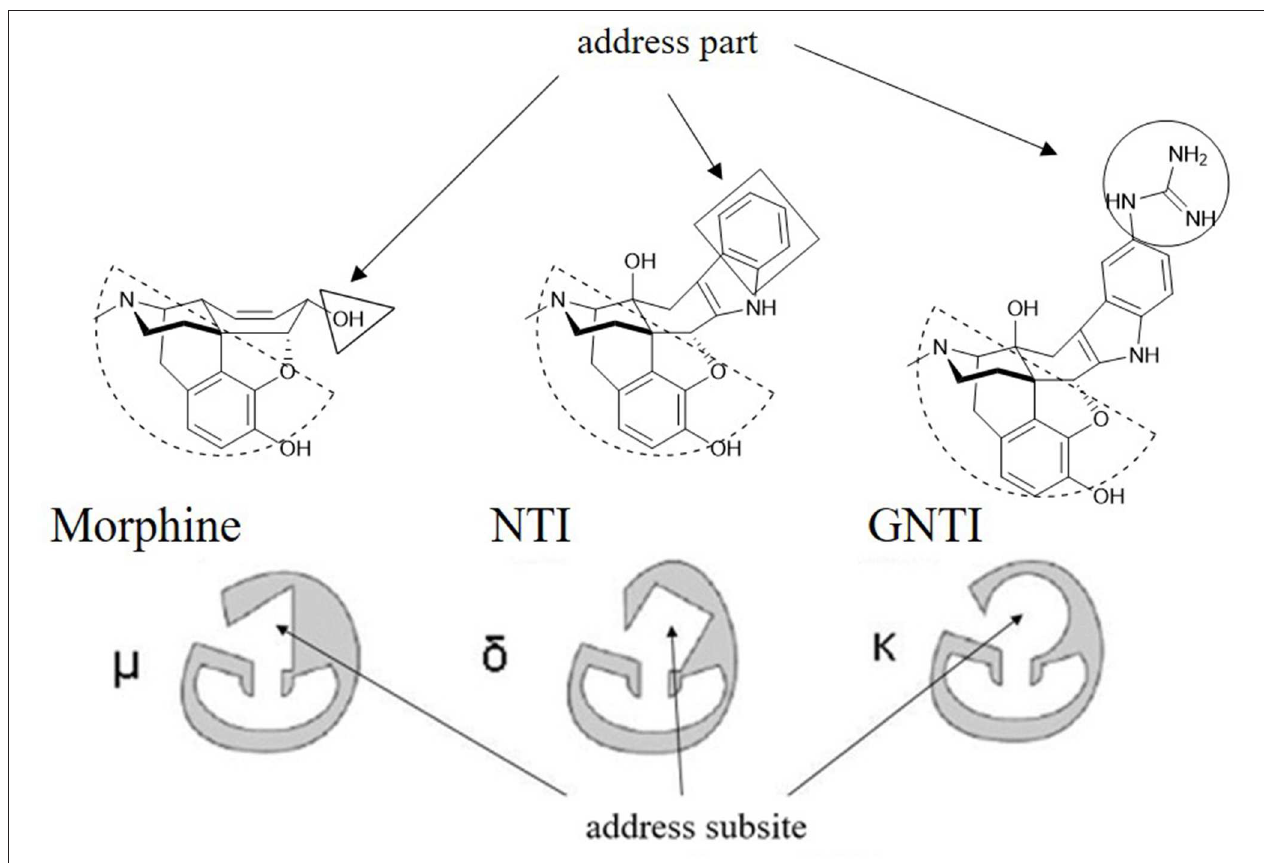
( Figure 3A ). Molecular docking operations were carried out to explore how compound 4 binds with the κ OR ( Figure 3B